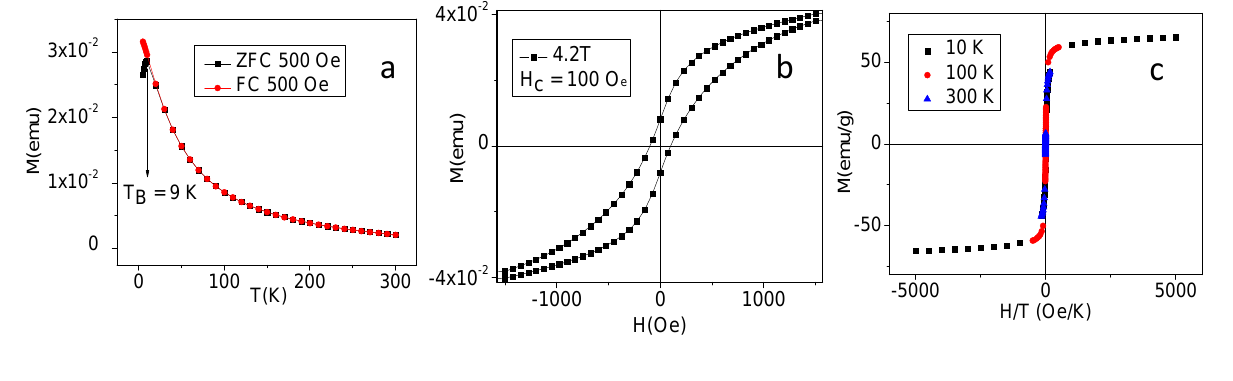
shows coercive field (H B , coercive field (H ) is B c